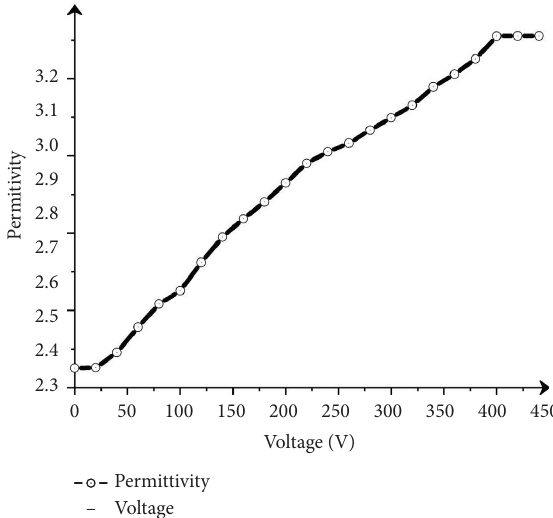
Figure 1: Te permittivity of liquid crystal versus bias voltage.